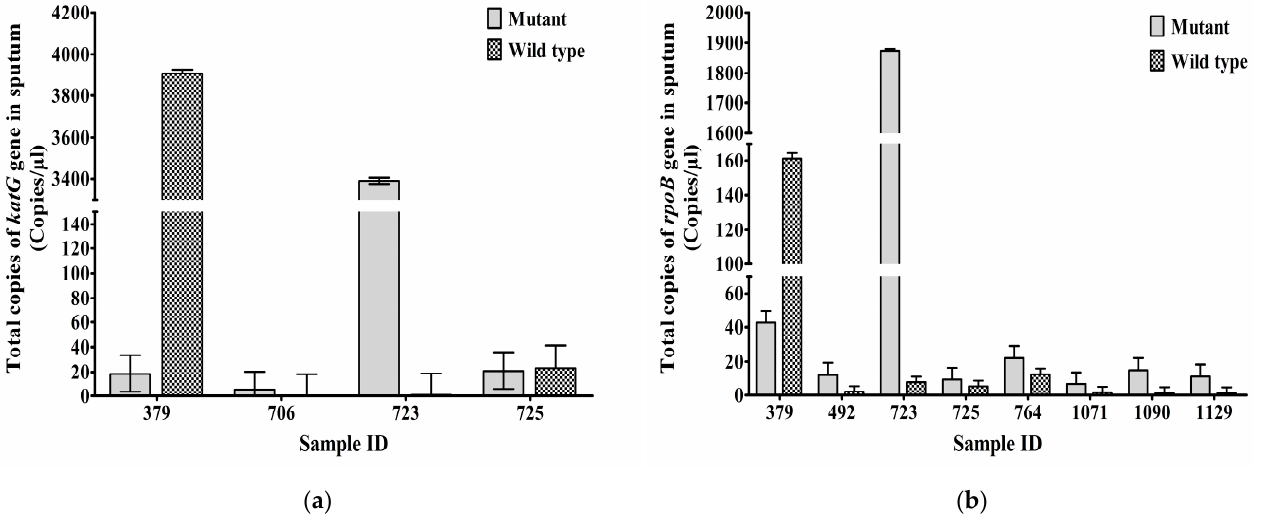
Figure 3. Total MT and WT copies (Mean± SEM) of ( a ) katG gene at codon 315 of INH-resistant TB, ( b ) rpoB gene at codon 531 of RIF-resistant TB, in sputum (CPM). Mean ± SEM is shown with error bars where SEM is computed by dividing standard deviation (SD) by the square root of the count (N).